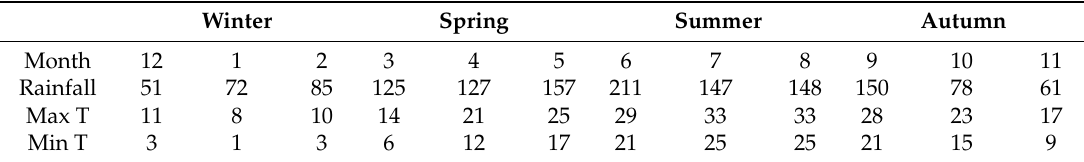
Table 1. The average of rainfall and temperature (T) in Lin’an District from 1951 to 2008 (mm, ◦ C). Winter Spring Summer Autumn Month 12 1 Rainfall 51 Min